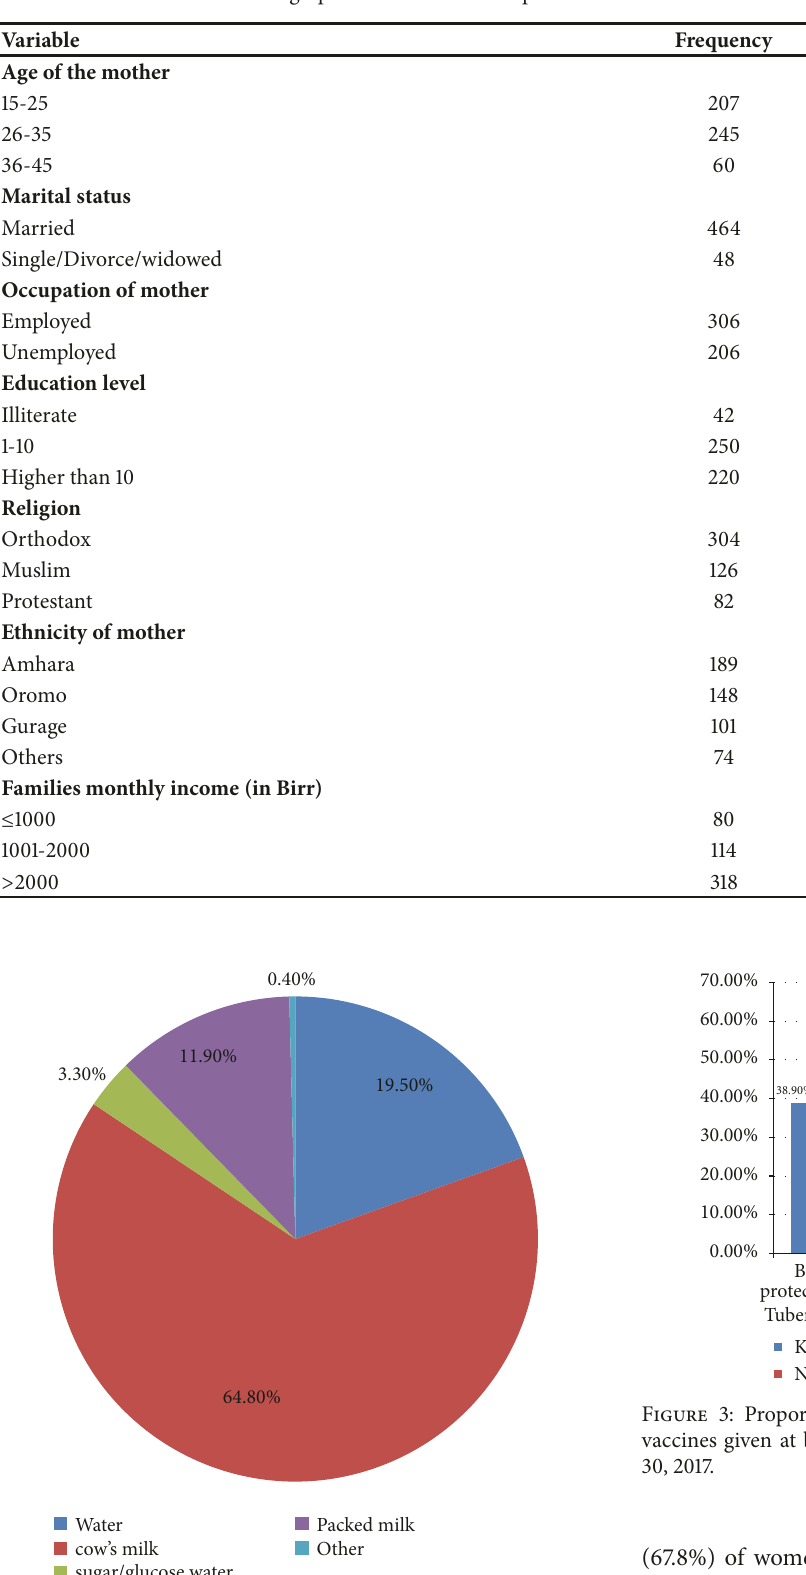
(67.8%) of women reported that eye discharge is the main symptom while reddening of eye accounts for 305(59.2%), 179 (35%) mentioned swollen eye, and 3 (0.6%) for other symptoms (see Figure